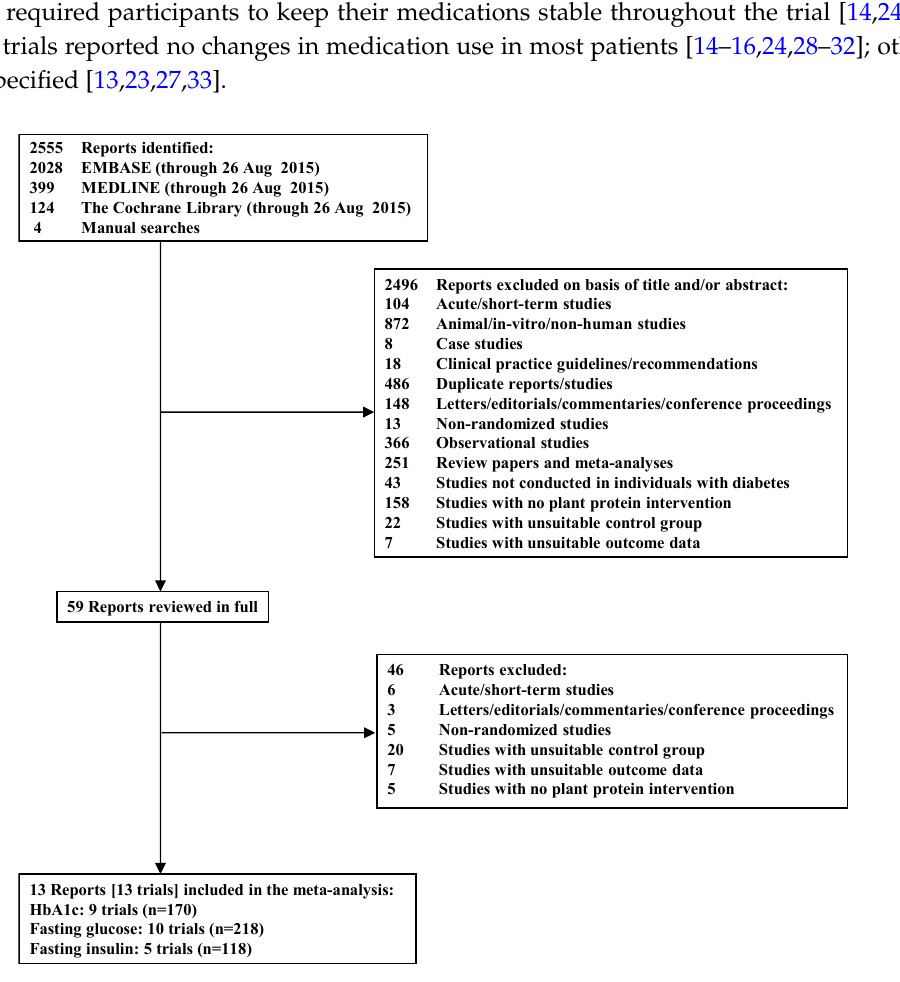
Figure 1. Flow diagram depicting the literature search and selection process.